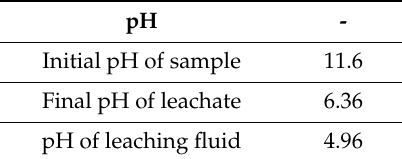
Table 5. pH values of bottom-ash based GPC.